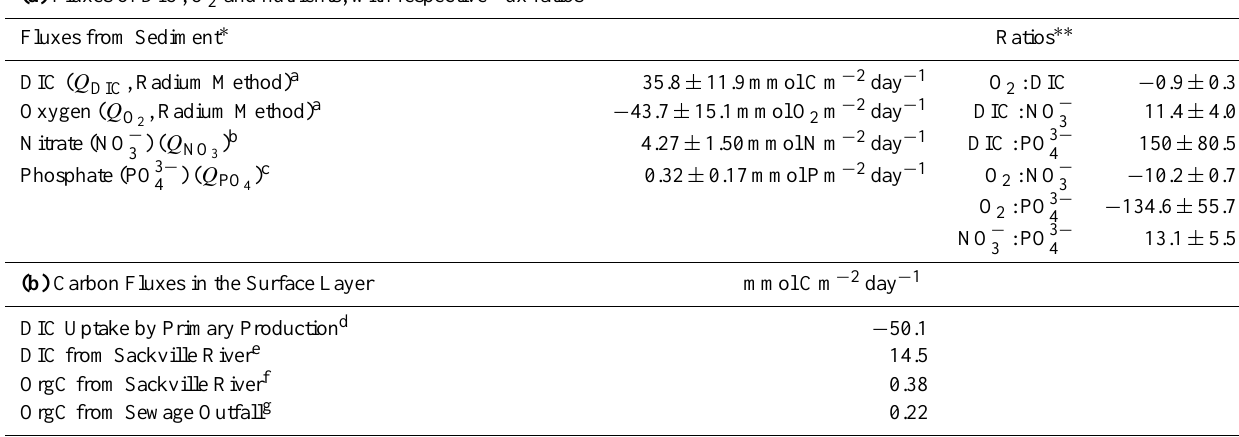
Table 3. Chemical fluxes in Bedford